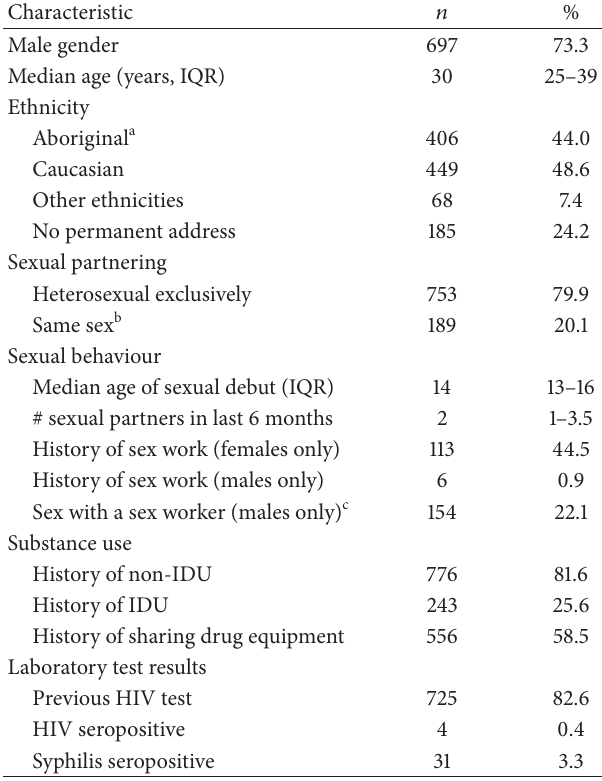
Table 2: Demographic and risk behaviour characteristics of